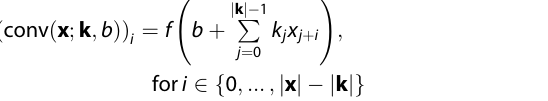
Table 1. Network architectures used for each fi gure. In all cases we used a tanh-activation function, a learning rate of 10 − 3 , N features per layer for N particles, and an exponential output function. [ x ] denotes the nearest integer function and ⌈ x ⌉ the ceiling function. Figure Network architecture Network boundary conditions Num. Layers L Kernel size K Num. Parameters